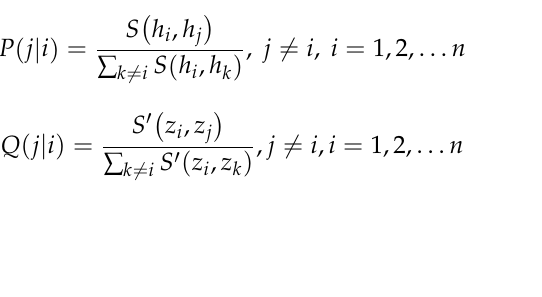
Figure 3. Architecture of the stacked denoising